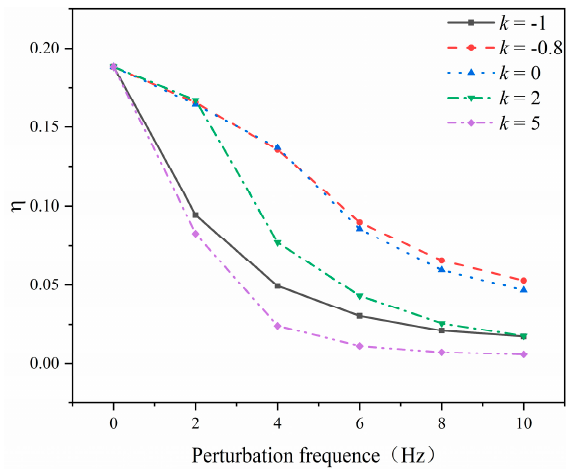
Figure 5. Variation of propulsion efficiency.